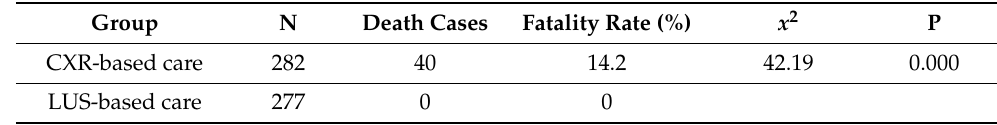
Table 2. The influence of LUS-based care on RDS fatality rate (%). Group N Death Cases Fatality Rate (%) x 2